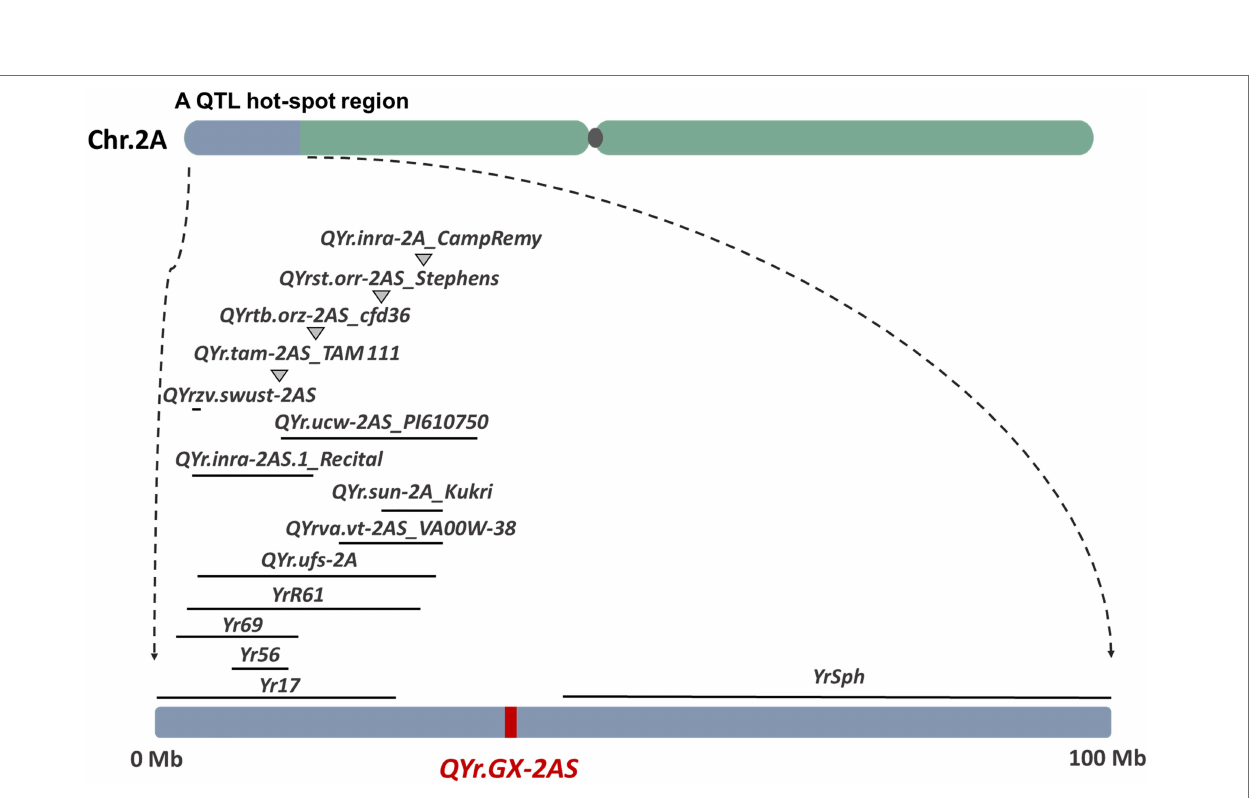
FIGURE 6 | Comparison of QYr.GX-2AS with previously identified genes/QTL (from biparental population) for resistance to stripe rust based on the reference genome of bread wheat (IWGSC, RefSeq